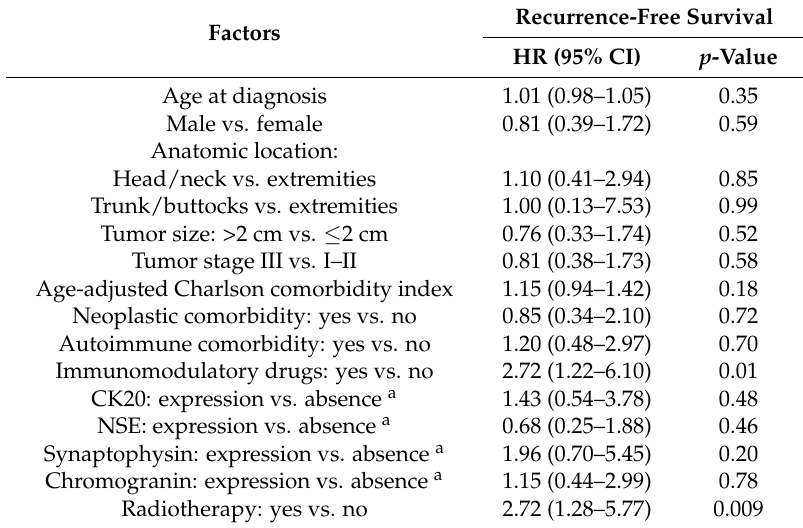
Figure 4. Recurrence -free survival among patients with primary stage I–III MCC. Table 3. Factors associated with recurrence-free survival among patients with primary stage I–III tumor.